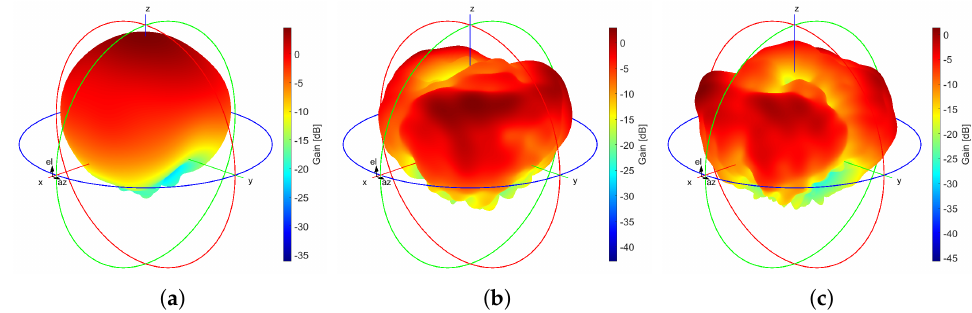
Figure 8. Realized gain plots (computed results) of the modified E-shaped patch antenna (color scale in dB) ( a ) freq = 866.4 MHz, ( b ) freq = 1841 MHz, and ( c ) freq = 1957 MHz.